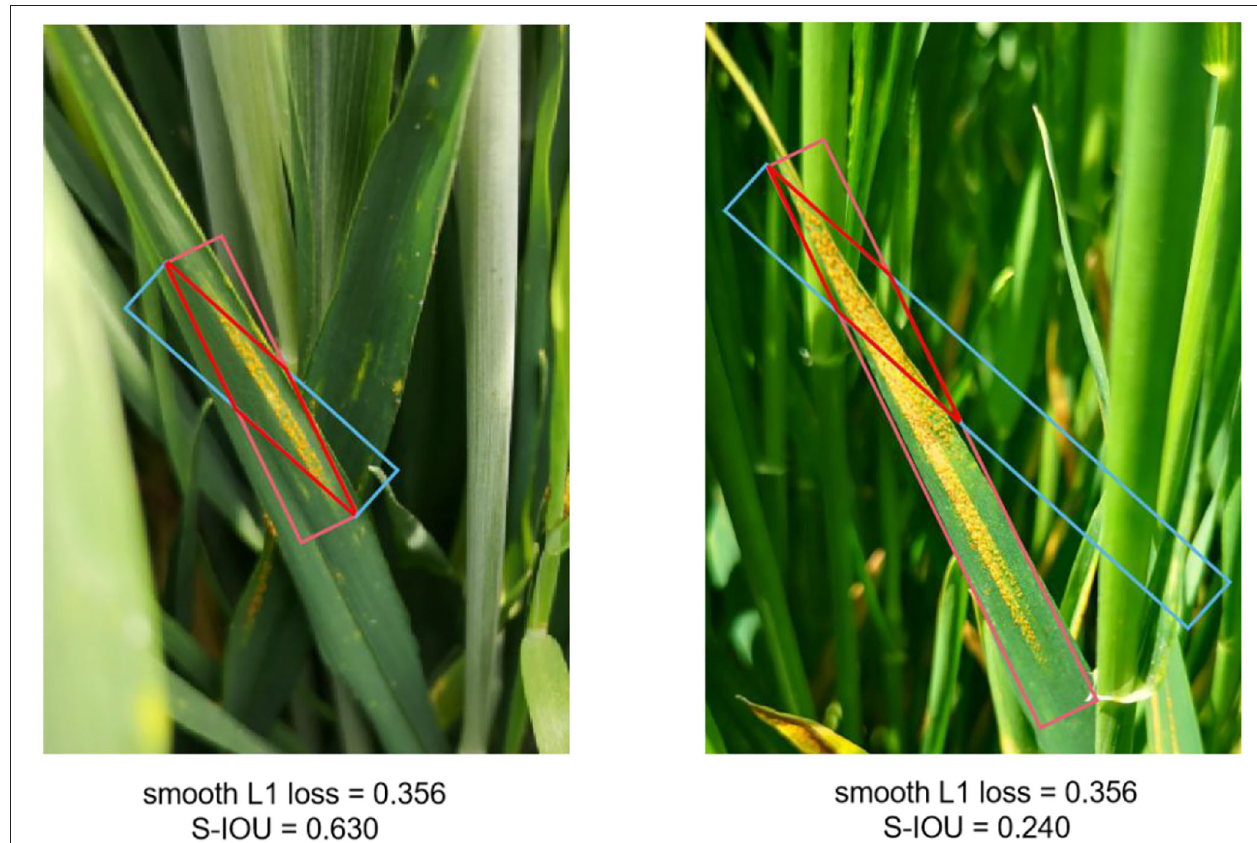
FIGURE 12 | Comparison between S-IoU and Smooth L1 loss.